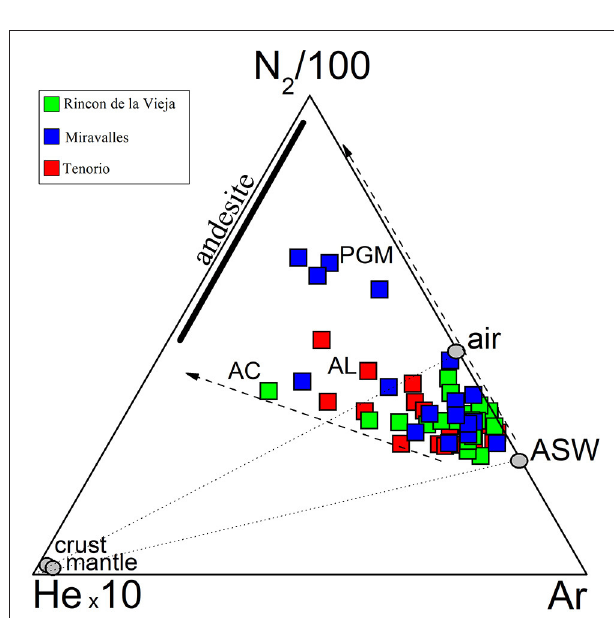
FIGURE 3 | N 2 /100-He × 10-Ar triangular diagram (Giggenbach, 1992). Symbols as in Figure 1